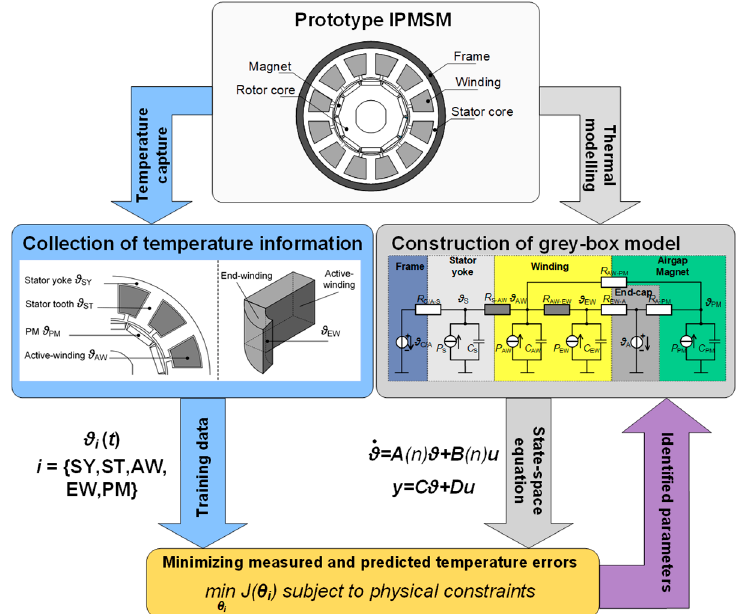
Figure 40. Identification procedure of grey-box thermal model.